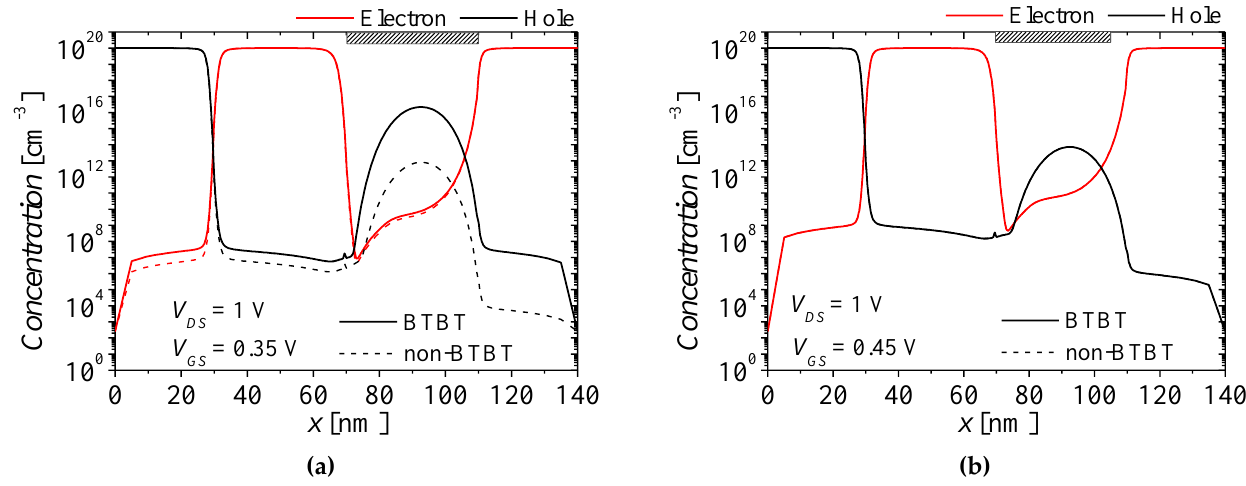
Figure 9. Comparison of carrier concentrations on surface region when BTBT is considered and ignored at V DS = 1 V. ( a ) V GS = 0.35 V and ( b ) V GS = 0.45 V.